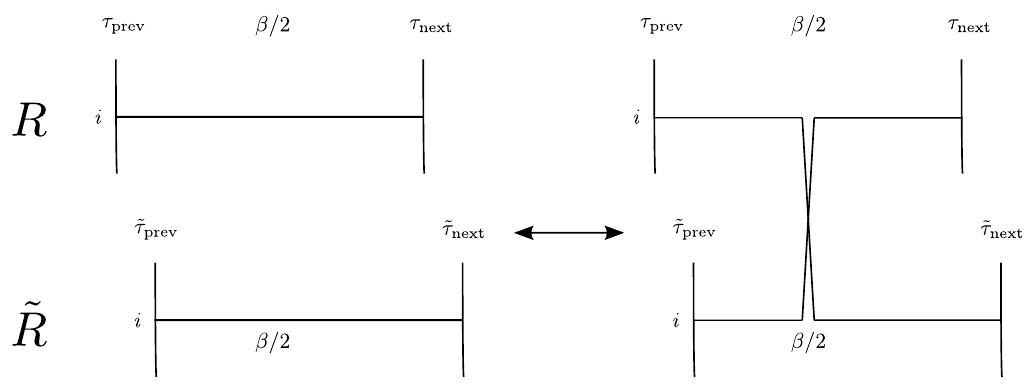
Figure 7: Insert / Delete SWAP kink. The number of particles at the center of the path, τ = β/ 2, is measured for the same site on the two different replicas. If the number of particles is the same, then the SWAP kink is inserted. The kinks are shown to form an “X” in the diagram for visual clarity, but they both exist at exactly β/ 2. Kink deletion occurs if the number of particles at β/ 2 is the same for site i of both system and replica. In the figure, the replicas are labeled R and ˜ R